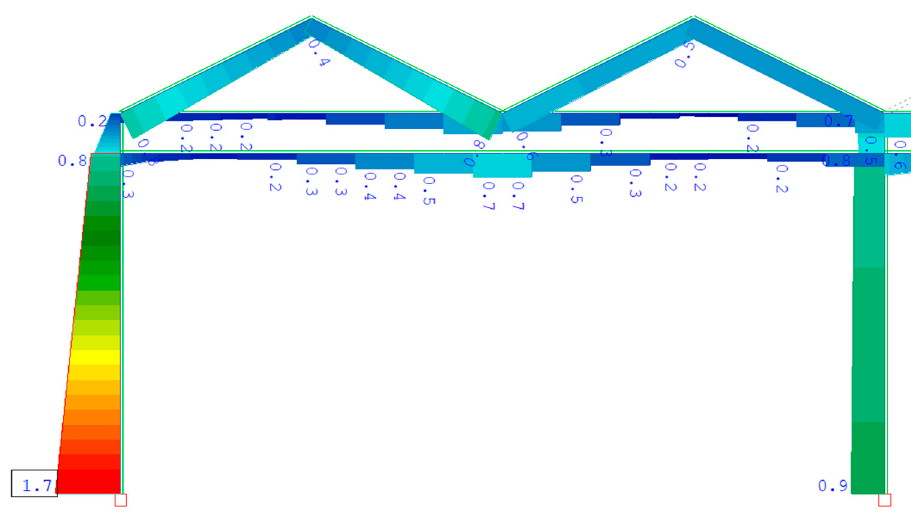
Figure 15. Horizontal displacement ( a ) perpendicular and ( b ) parallel to the gutter. Table 7. Limits of horizontal displacements. Table 8. Design inadequacies of the two greenhouses.